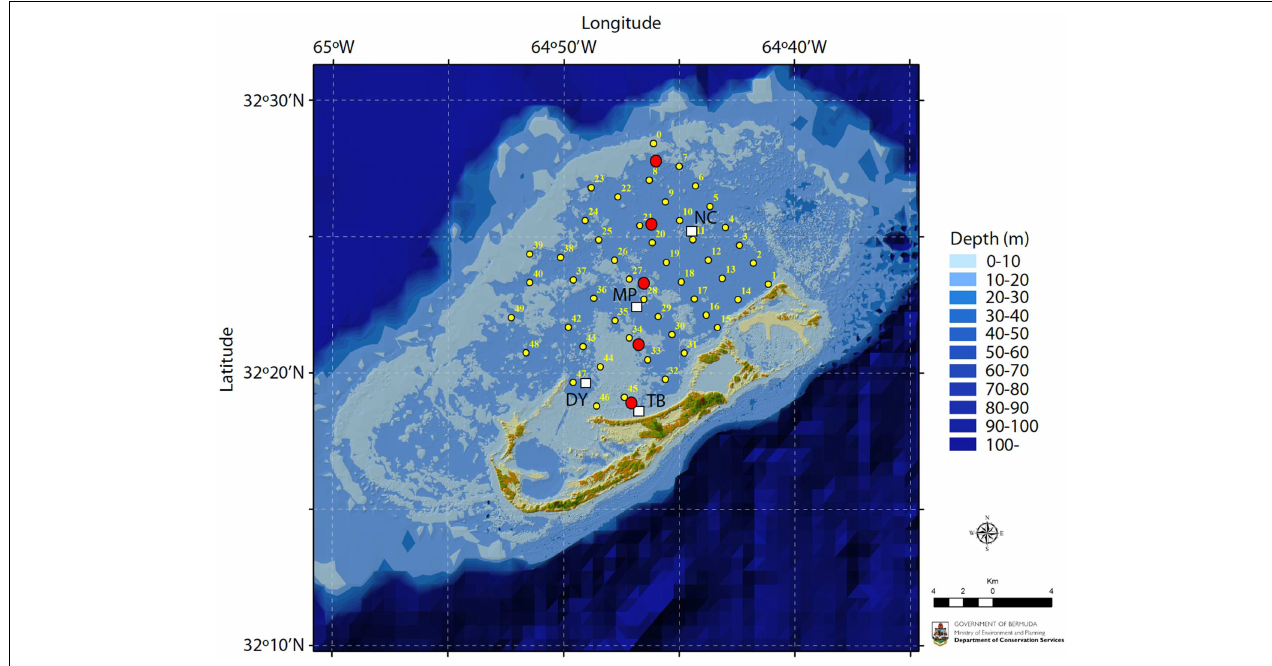
FIGURE 1 | Map of the Bermuda coral reef platform. Surface seawater samples were collected monthly at stations TB, DY, MP, and NC between 2007–2012 (white squares) and in the winter and summer of 2010 at stations 1–49 (small yellow circles). Pore water